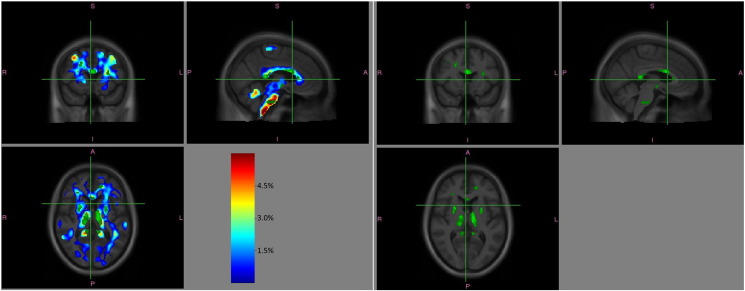
Yearly rate of additional WM fractional volume reduction for patients beyond that seen in controls (left). The colorbar is set to 0–6%. The right-hand-side panel shows for comparison on the same sections the areas of significant differences in yearly rates of WM volume reductions in patients vs controls as shown in Fig. 2B (FDR p < 0.05).